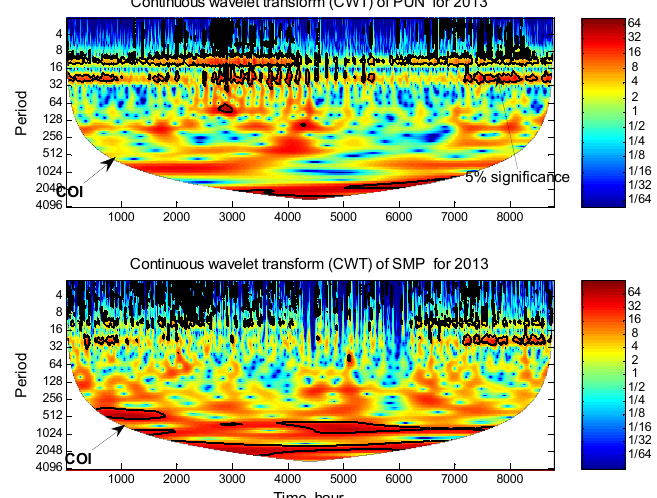
Figure 10. The continuous wavelet power spectrum of the PUN and SMP time series for 2013. The thick black contours designate the 5% significance level against red noise and the cone of influence, COI, where edge effects might distort the picture is shown as a white region. The AR (1) lag-1 coefficients are 0.86 and 0.82 for PUN and SMP